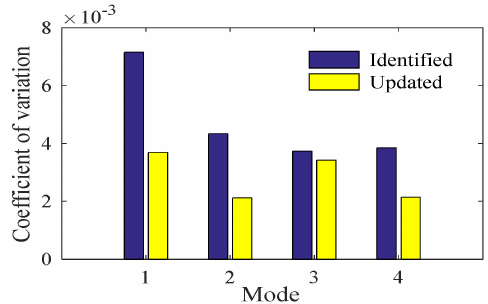
Figure 23. Variation coe ffi cients of the first four modal